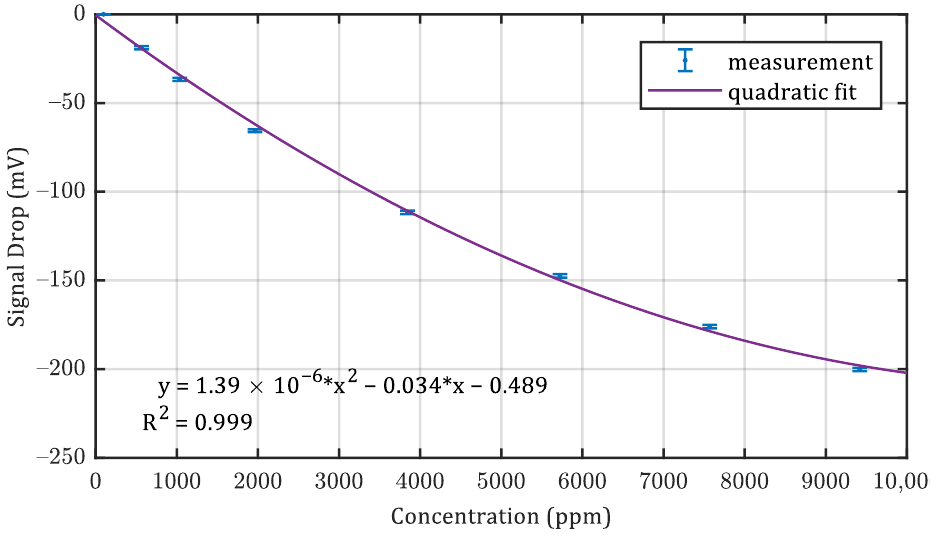
Figure A3. Additional absorption, simulated with HITRAN, for applied CO 2 concentrations in the sensor path, normalized to the absorption of each absorption path at the measurements’ lowest CO 2 concentration. Only the direct distance was calculated. Reflections inside the reflector tube were neglected.